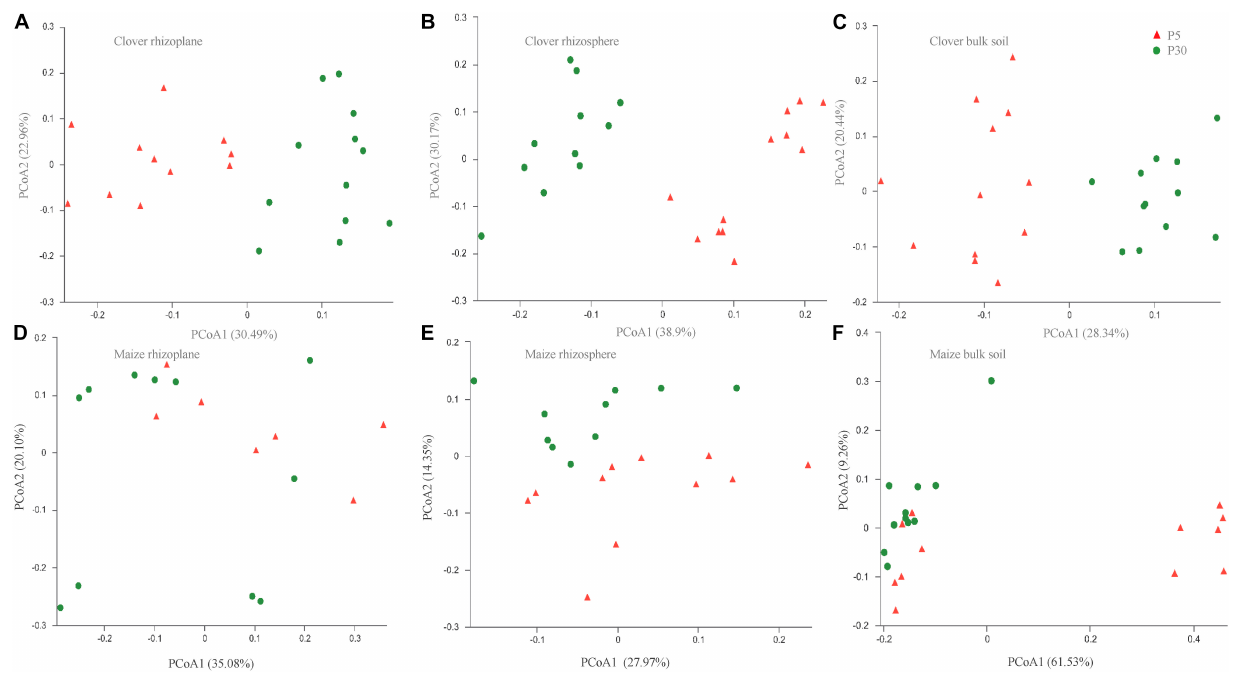
FIGURE 4 | Bacterial communities in different rhizocompartments (rhizoplane, rhizosphere, and bulk) of clover and maize plants in response to substrate P levels. (A) Clover rhizoplane; (B) clover rhizosphere; (C) clover bulk; (D) maize rhizoplane; (E) maize rhizosphere; and (F) maize bulk. Principal coordinate analysis (PCoAs) plots of the OTU-based Bray–Curtis distance between all samples. The variance explained by each PC axis is given in parentheses. P5 and P30 represented the substrate P fertilizers with 5 and 30 mg P kg – 1